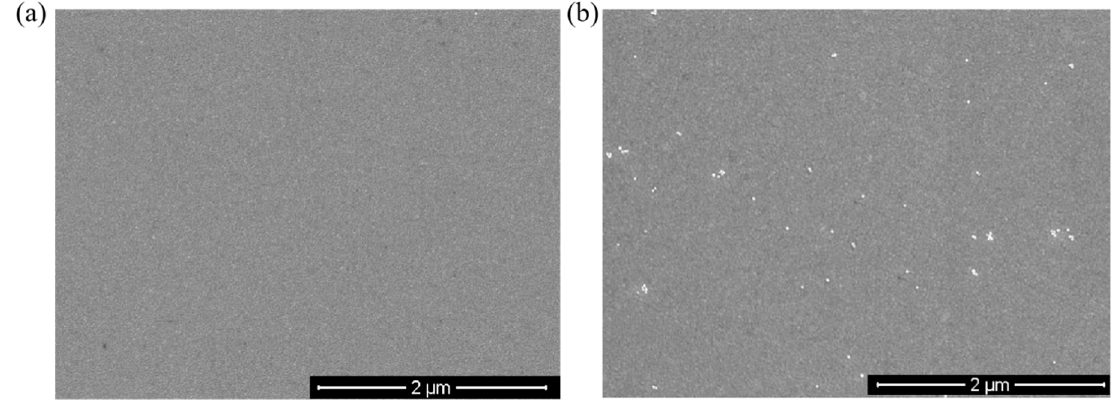
Figure 6. SEM image of sensing surface after the detection of Hg 2+ ions: ( a ) without Hg 2+ ; ( b ) the presence of Hg 2+ .